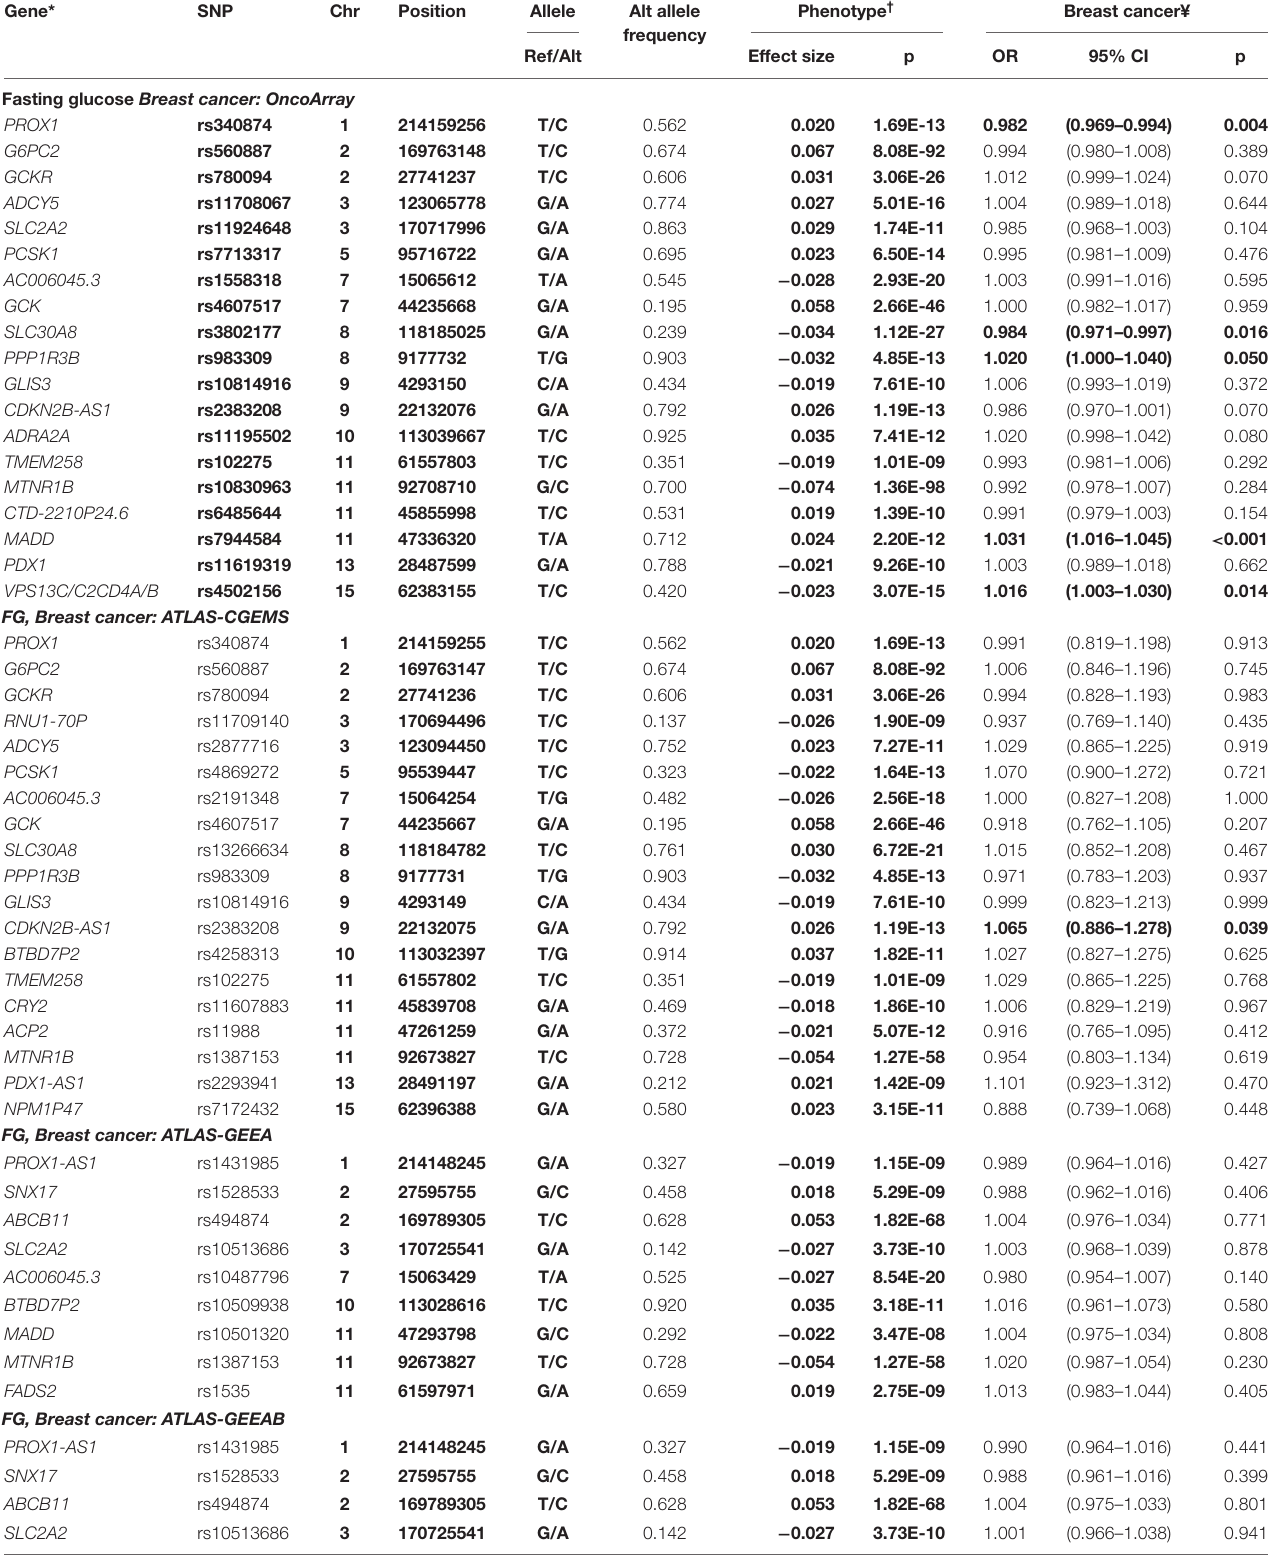
TABLE 1 | Top GWA SNPs associated with glucose-metabolism phenotypes and breast cancer risk.